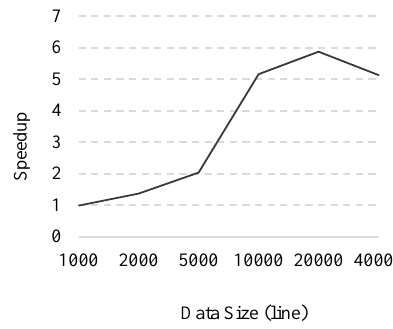
Figure13. Speedup comparison on the whole parallel algorithm for different size of